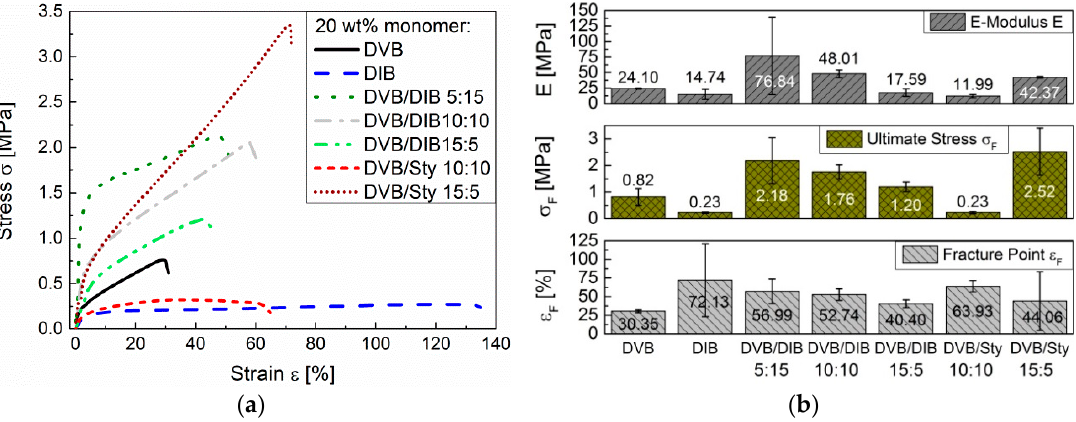
Figure 14. Ductility experiments of terpolymer specimens: ( a ) stress–strain diagram; ( b ) ductility parameters ( E -Modulus E , Ultimate Stress σ F and Fracture Point ε F ). Constant total incorporated monomer content: 20 wt %.